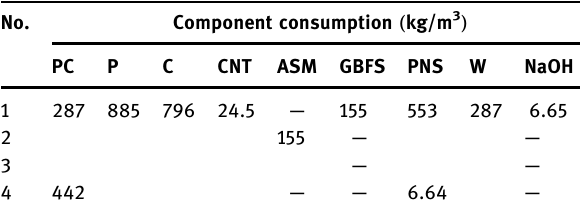
Table 14: Compositions of nano - modi fi ed concrete mixtures No.